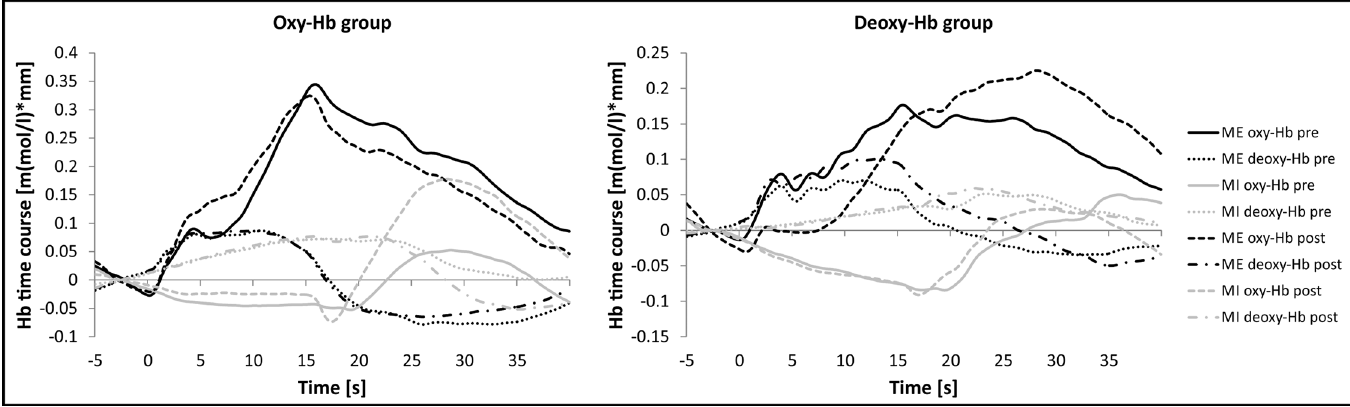
Fig 6. NIRS time course during MI and ME of swallowing. Mean activation changes in oxy- and deoxy-Hb in response to motor execution (ME, black lines) and motor imagery (MI, gray lines) over the inferior frontal gyrus, presented separately for the pre- (full lines) and post-measurement (dotted lines) and the oxy-Hb group (left panel) and deoxy-Hb group (right